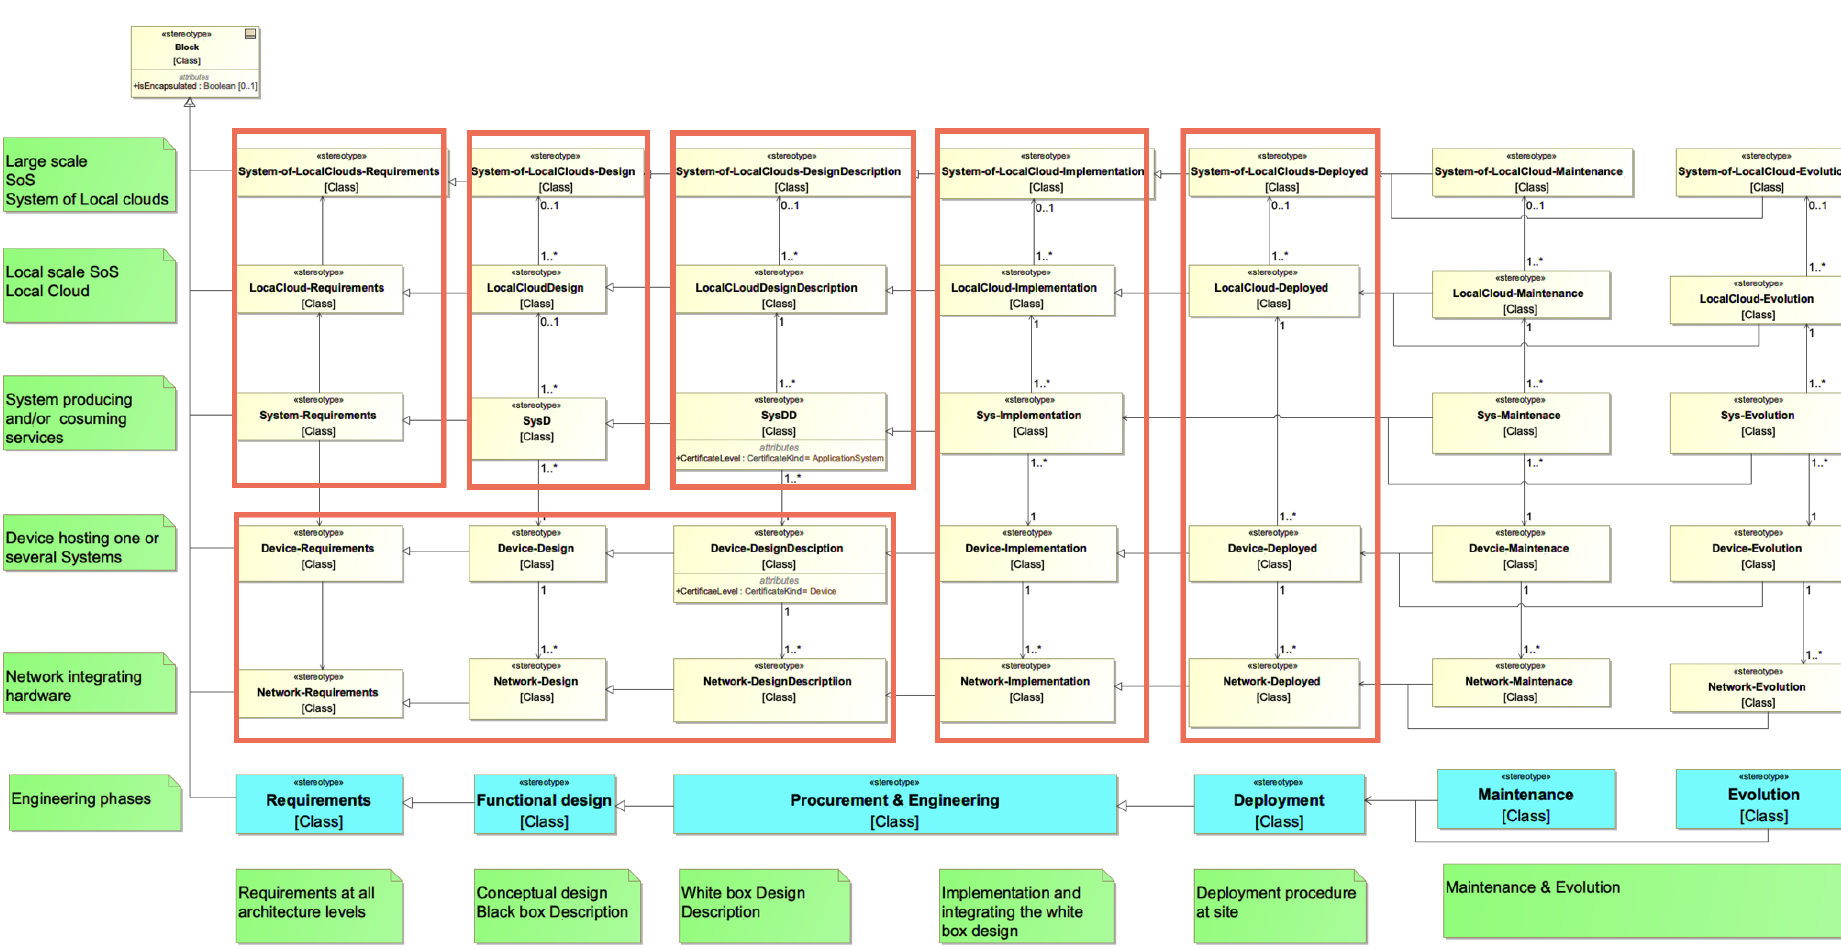
Figure 11. The proposed engineering flow through the architecture–engineering process